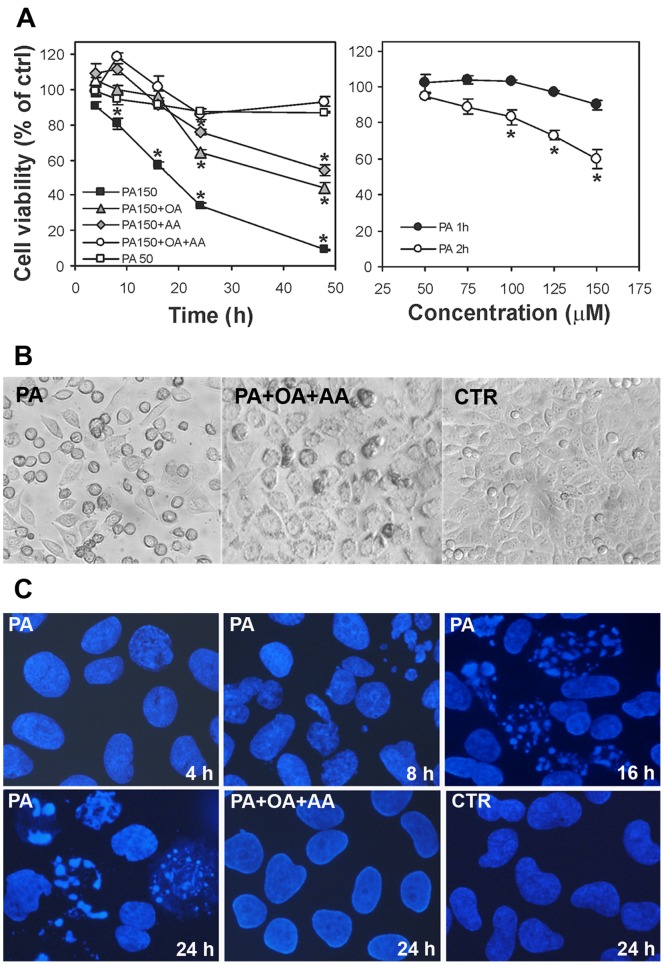
Effect of PA on NB100 cell line and cell morphology.(A) Effect of FA supplementation on NB100 cell viability. Cell viability was determined by MTS assay. Values are means ± SD of four determinations. Left graph: cells were incubated in complete medium supplemented with 50 µM PA (□), 150 µM PA (▪), 150 µM PA +50 µM OA (♦), 150 µM PA +50 µM AA (▴), 150 µM PA +50 µM OA +50 µM AA (○). Right graph: cells were incubated in complete medium supplemented with PA at various concentrations for 1 hour (•) or for 2 hours (○), and then incubated in complete medium for 48 hours after wash. (B) NB100 cells morphology assessed by phase contrast microscopy. Control cultures grown in the absence of FA supplementation are shown in comparison with cells treated for 24 hours with 150 µM PA or 150 µM PA +50 µM OA +50 µM AA. Magnification 200×. (C) Nuclei of NB100 cells stained with DAPI and assessed by fluorescence microscopy (×600 magnification objective). Cells were incubated in complete medium supplemented with 150 µM PA (4, 8, 16, 24 hours) or 150 µM PA +50 µM OA +50 µM AA (24 hours). Control cultures grown in the absence of FA supplementation (24 hours) are also shown.